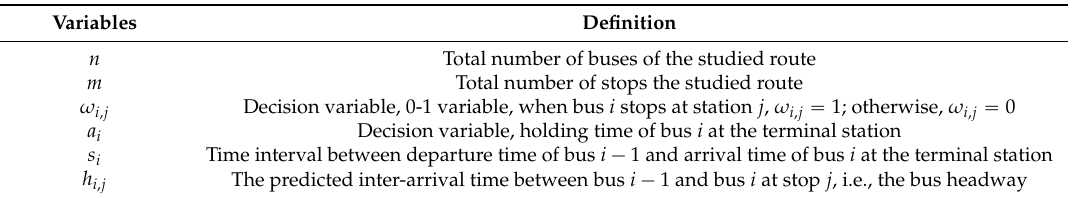
Table 1. The definition of key variables.